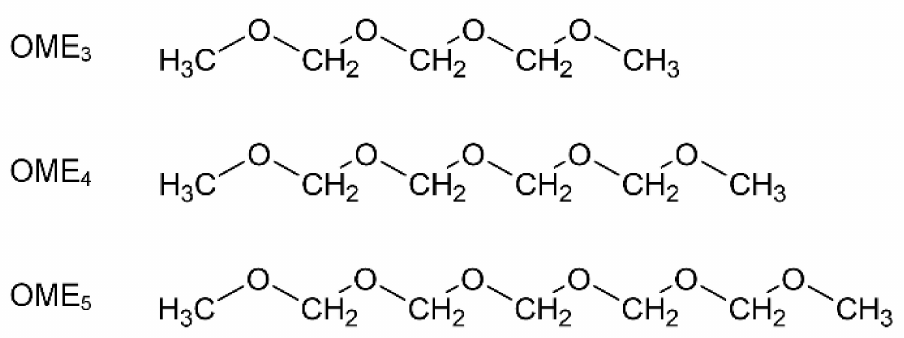
Figure 1. Molecular structures of OME 3 , OME 4 , and OME 5